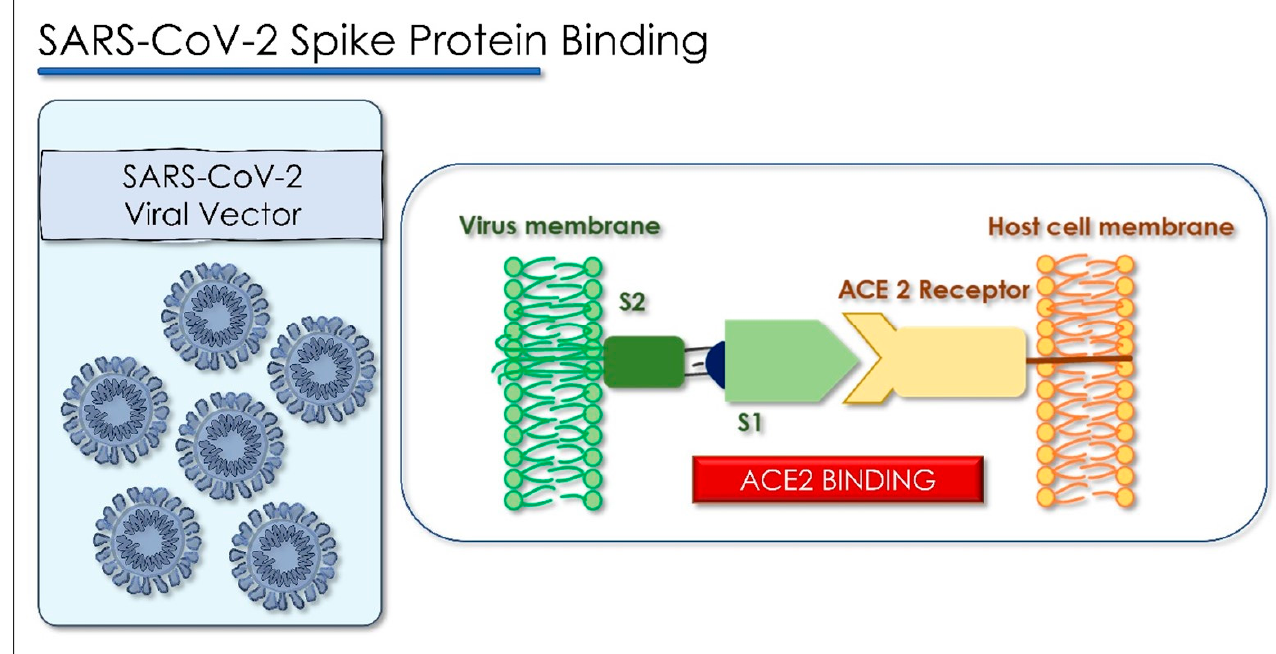
Figure 5. Details of the SARS-CoV-2 S Spike protein (S) binding with ACE2 human receptors.